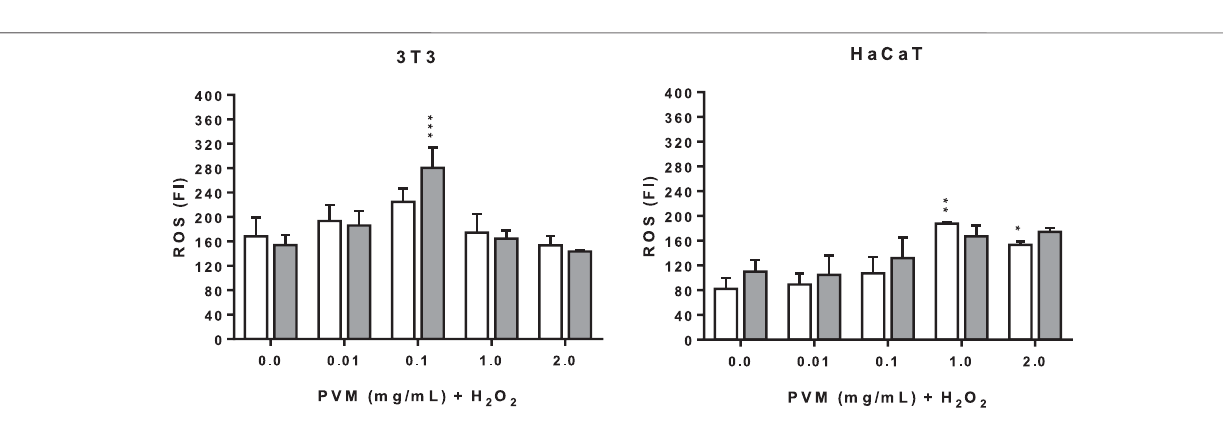
Frontiers in Pharmacology |